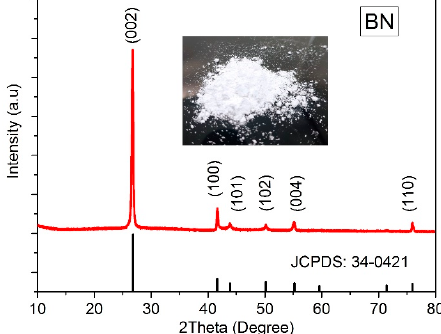
Figure 2. The XRD characteristic of the BN NPs.